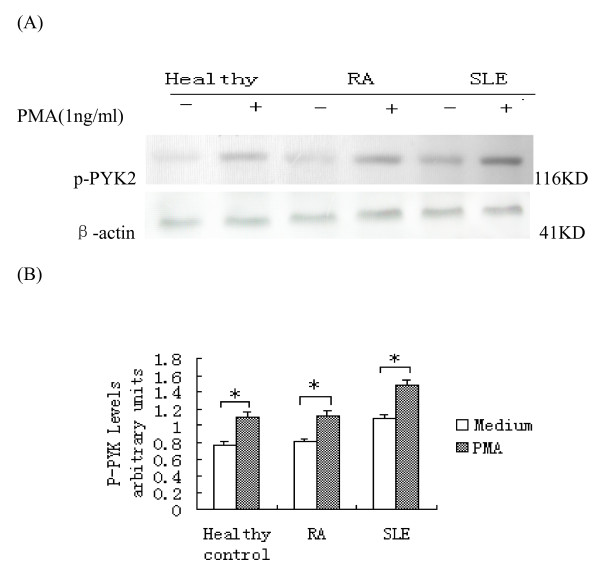
Enhanced PYK2 phosphorylation in PBMCs in response to lymphocyte activation stimulated by PMA. (A) PBMCs obtained from healthy donors (n = 24), RA patients (n = 32) and SLE patients (n = 48) were incubated in 24-well culture dishes in 5% CO2 at 37°C for 24 h for with no stimulation (medium), or stimulation with PMA (1 ng/ml). Lysates prepared from 2 × 106 cells were analyzed by western blotting for the expression of p-PYK2 as indicated in patients and methods. (B) p-PYK2 expressed relative to the value obtained with PMA stimulation. Bars represent the mean and standard deviation of three separate experiments. Statistical analysis: * = p < 0.05.